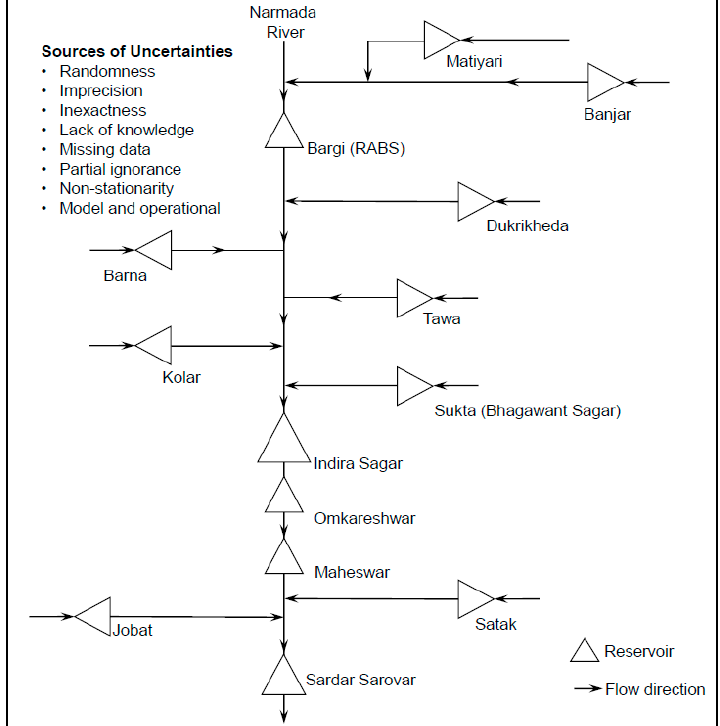
Figure 3. Integrated reservoir operation with major and medium reservoirs in Narmada river basin, India, modified from Mujumdar and Nagesh Kumar [12].